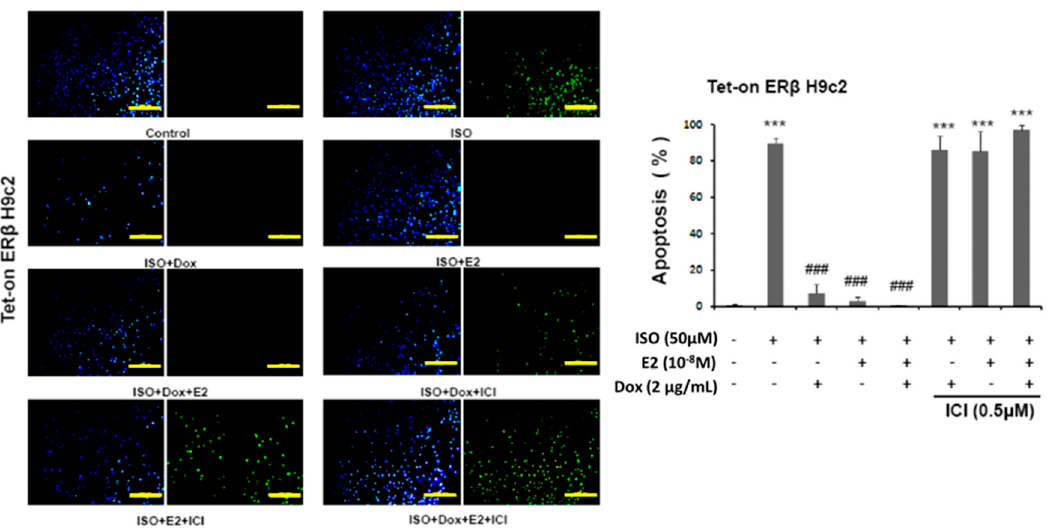
Figure 1. E2/ER β inhibits ISO-induced cellular apoptosis in Tet-on ER β H9c2 myocardial cells. Tet-on/ER α H9c2 cardiomyoblast cells were incubated with Dox (1 μ g/mL) and E2 (10 − 8 M) in presence or absence of ISO (50 μ M) and ICI (0.5 μ M) for 24 h, then TUNEL and DAPI double-staining were performed. The images were detected by fluorescent microscope and the number of apoptotic nuclei was counted (Bar length = 100 µ m). Mean ± S.D., n = 3. *** = p < 0.001 indicates significant difference with respect to the control group; ### = p < 0.001 indicates significant difference with respect to the ISO challenged